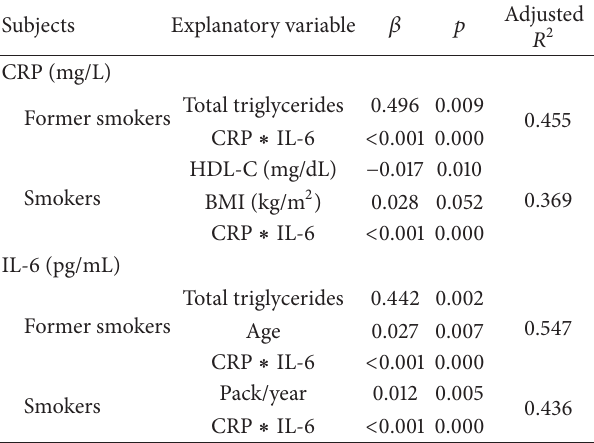
Table 3: Pearson’s correlation of CRP ∗ and IL-6 ∗ with each parameter by smoking status ( 𝑛 = 154).